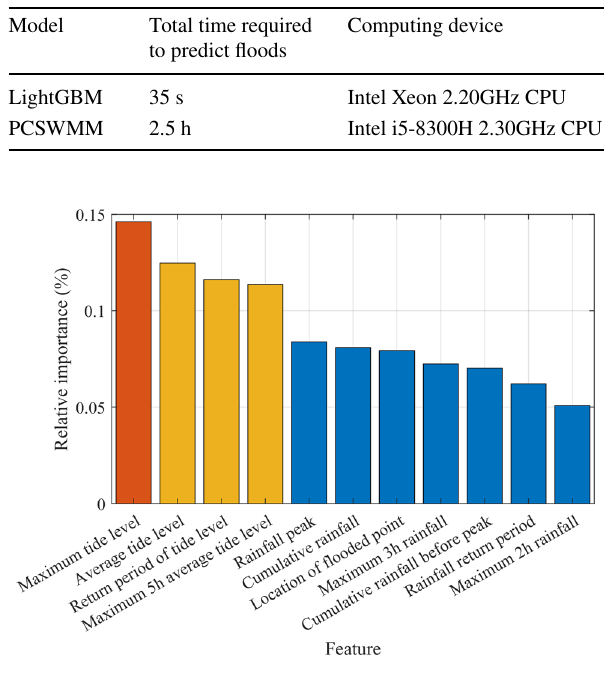
Fig. 12 Relative importance of urban flood conditioning factors based on the light gradient boosting machine (LightGBM)